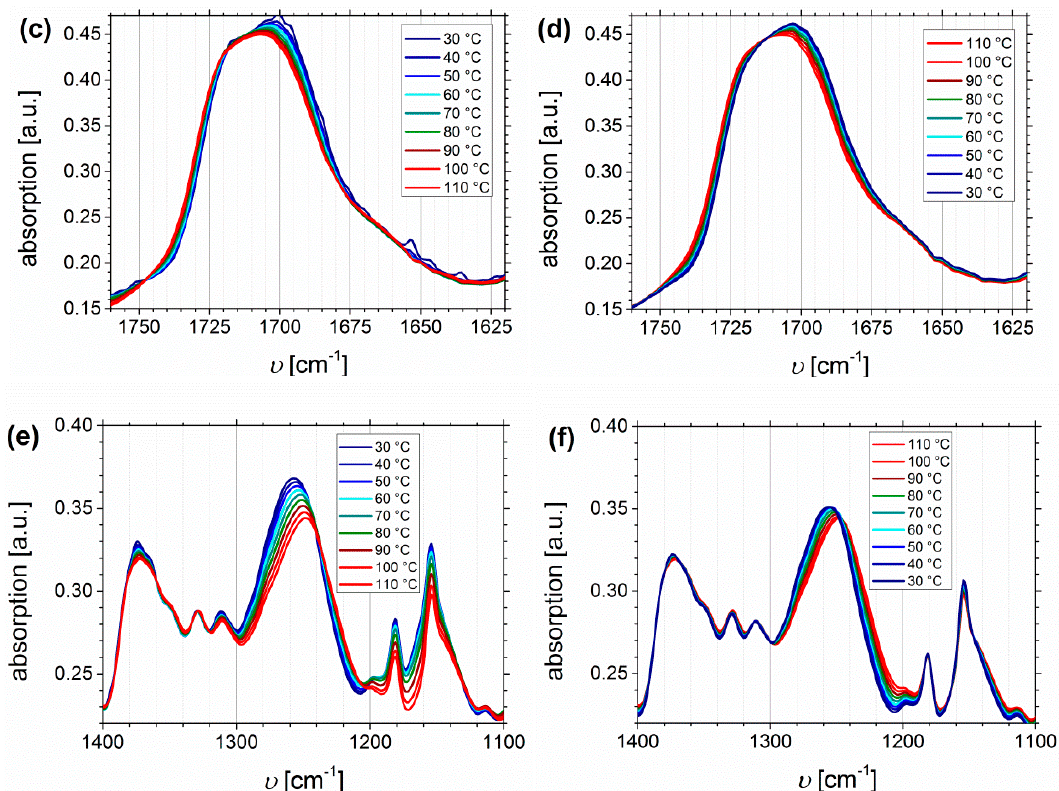
Figure 13. Temperature dependent FTIR spectra of I 5 S 90 I 562 ‐ DETA ( D f = 32%). Temperature range was 30 to 110 to 30 °C with 10 °C steps, and a 15 min isothermal hold at each temperature (( a , c,e ): Heating curves; ( b , d , f ): Cooling curves).